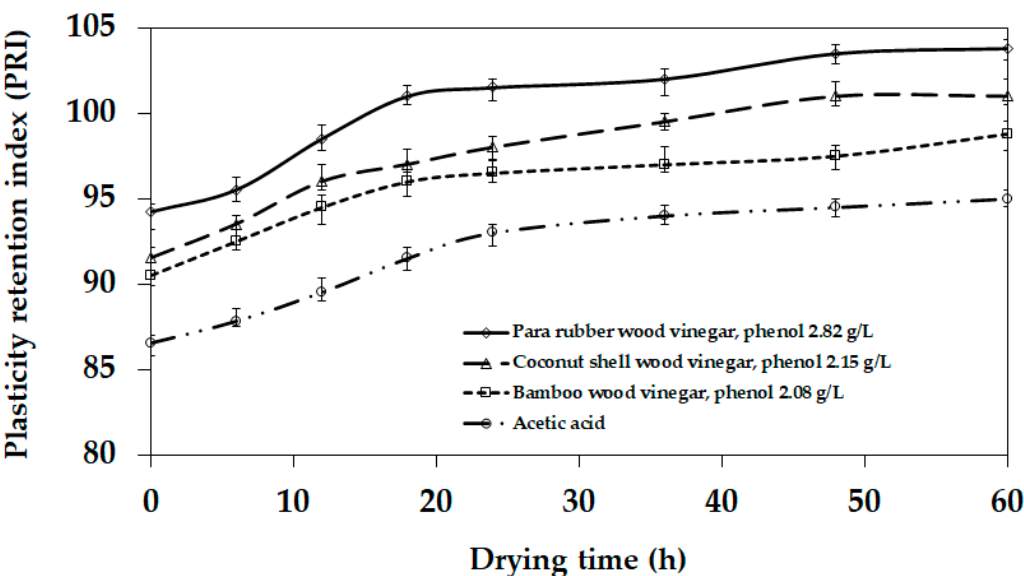
Figure 4. Plasticity retention index change during the drying process.